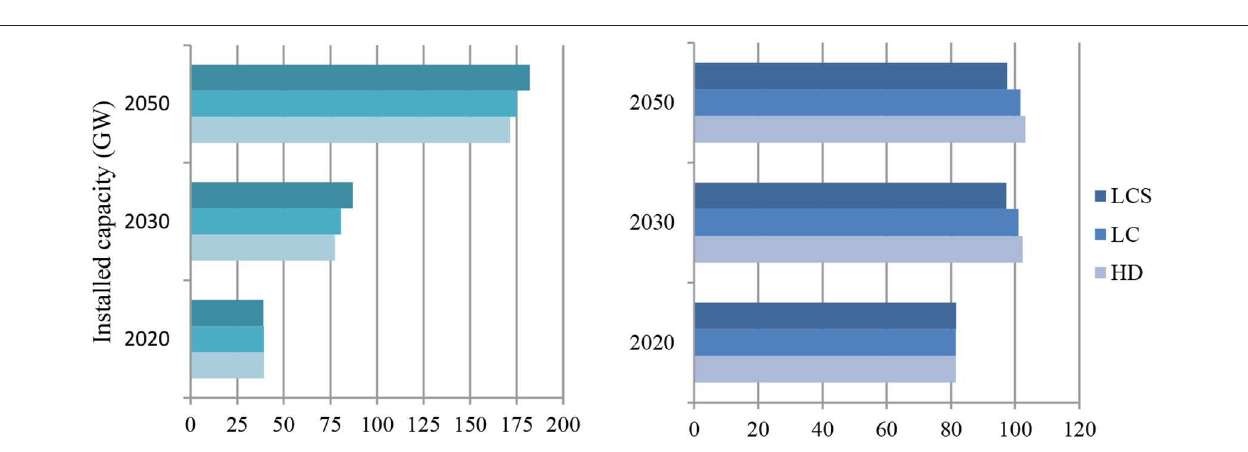
Figure 3 Installed capacity and power generation (from left to right: LD, REF, and HD